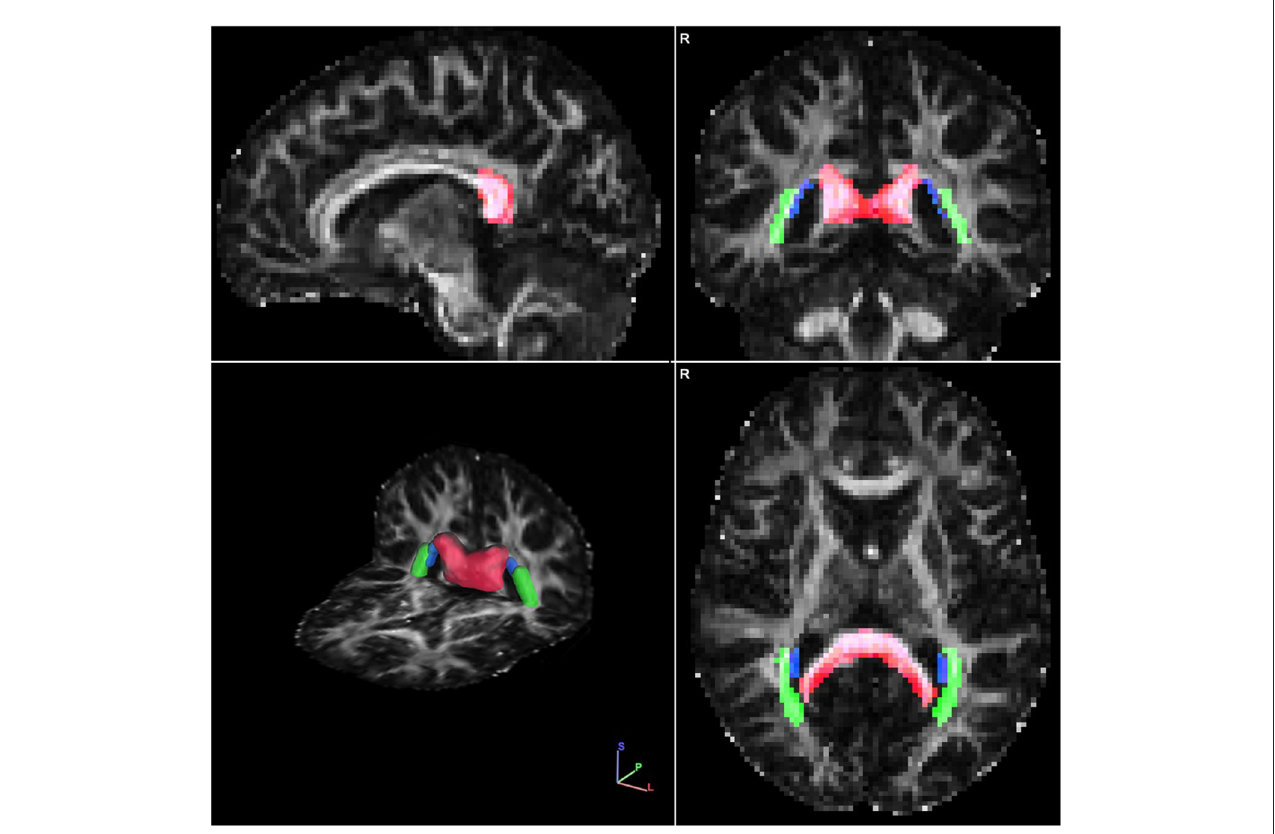
FIGURE1 Single representative diffusion fractional anisotropy (FA) map with the localized posterior tract ROIs overlayed in sagittal (Upper left quadrant) , coronal (Upper right quadrant) , axial (Bottom right quadrant) and 3-dimensional (Bottom left quadrant) views. The ROIs include: splenium of the corpus callosum (red), tapetum (blue), and posterior thalamic radiations (green). Images are displayed in radiological